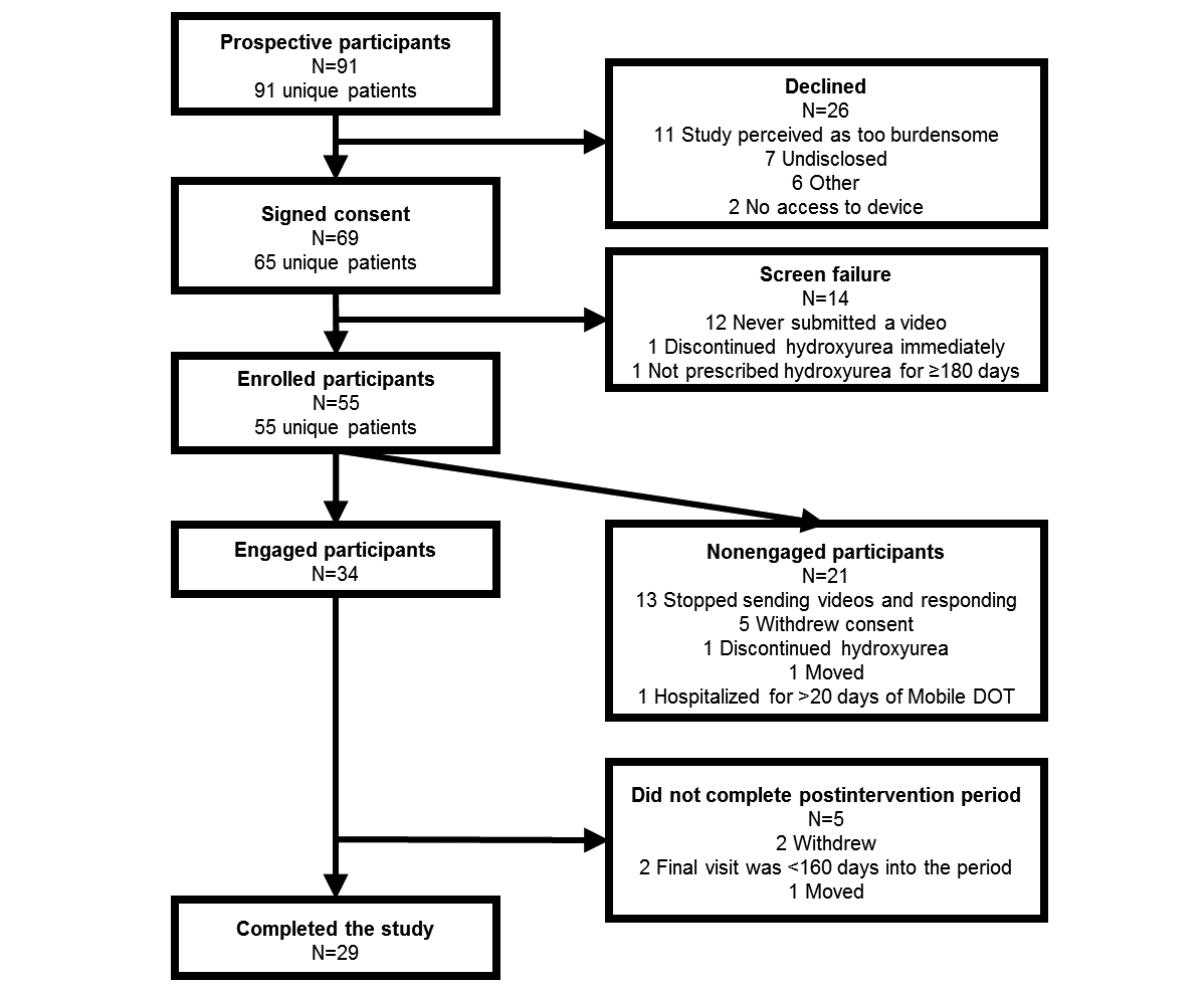
Figure 1. Participant flow diagram (Mobile DOT: Mobile Directly Observed